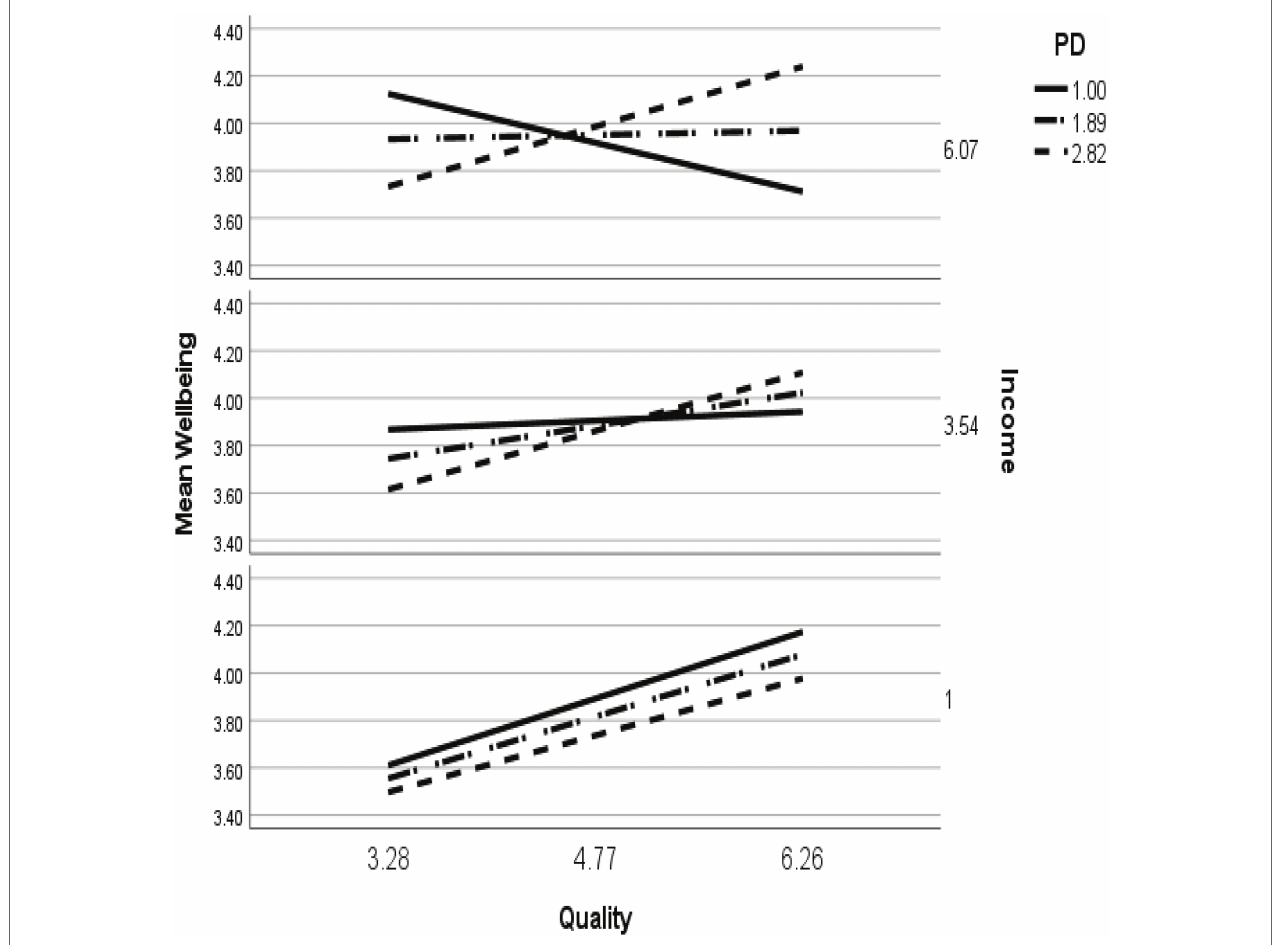
FIGURE 6 | Simple slopes of PQI predicting academic well-being for values of income and PD at 1 SD below the mean, the mean, and 1 SD above the mean for South African